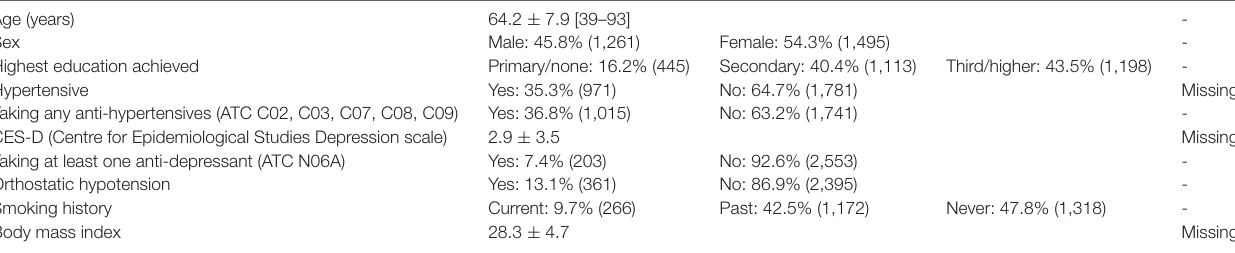
TABLE 1 | Characteristics of the